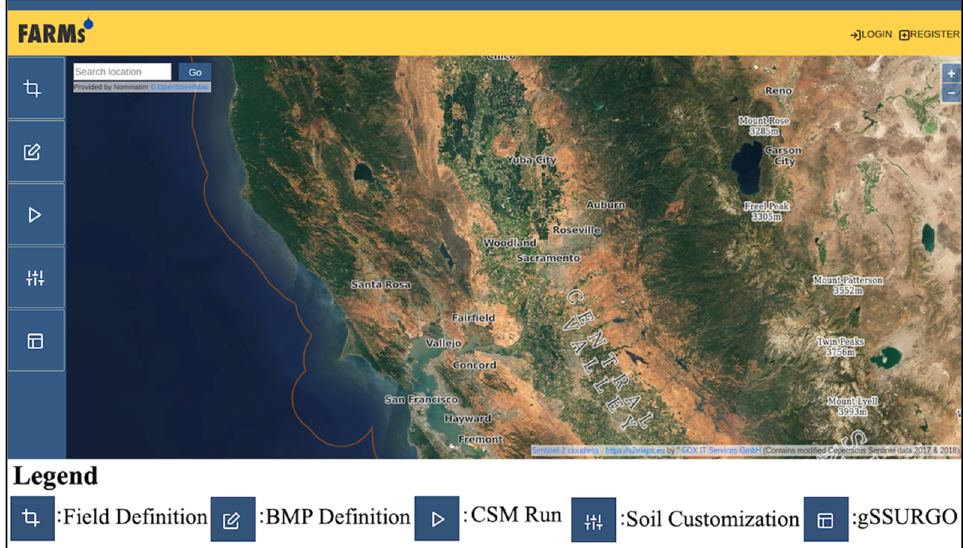
Figure 2. FARMs Main Portal (For base layer: Sentinel-2 cloudless—https://s2maps.eu by EOX IT Services GmbH (Contains modified Copernicus Sentinel data 2017 and 2018), accessed on 16 August 2021).